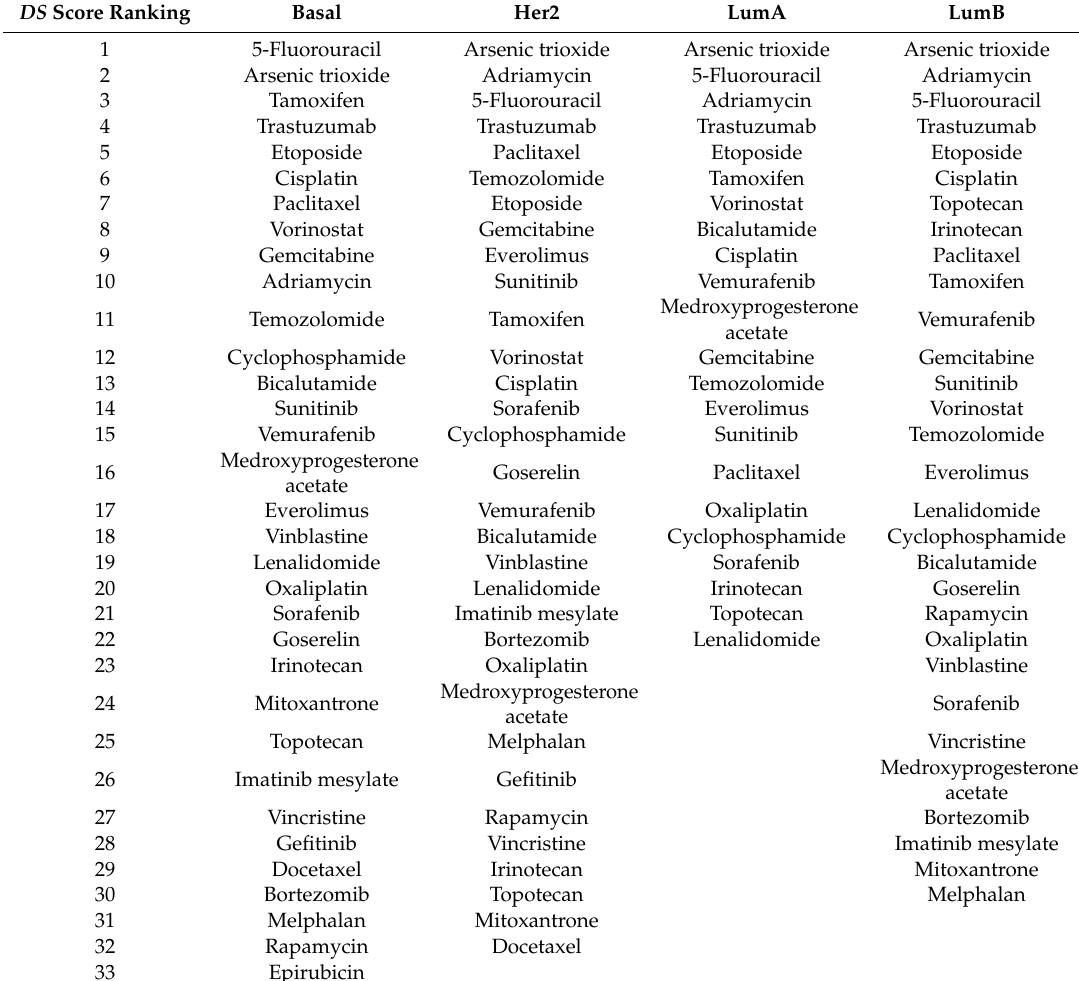
Table 1. Screened candidate drugs for various subtypes of breast cancer based on DS score. DS Score